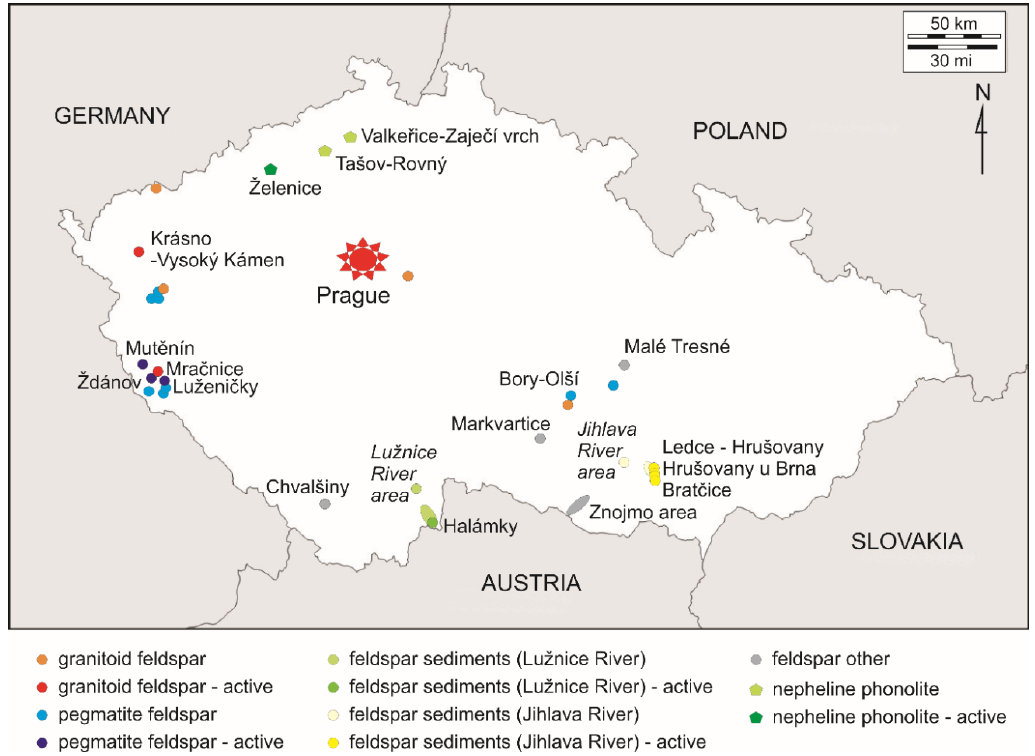
Figure 1. Locations of feldspar and feldspathoid rock deposits in the Czech Republic.